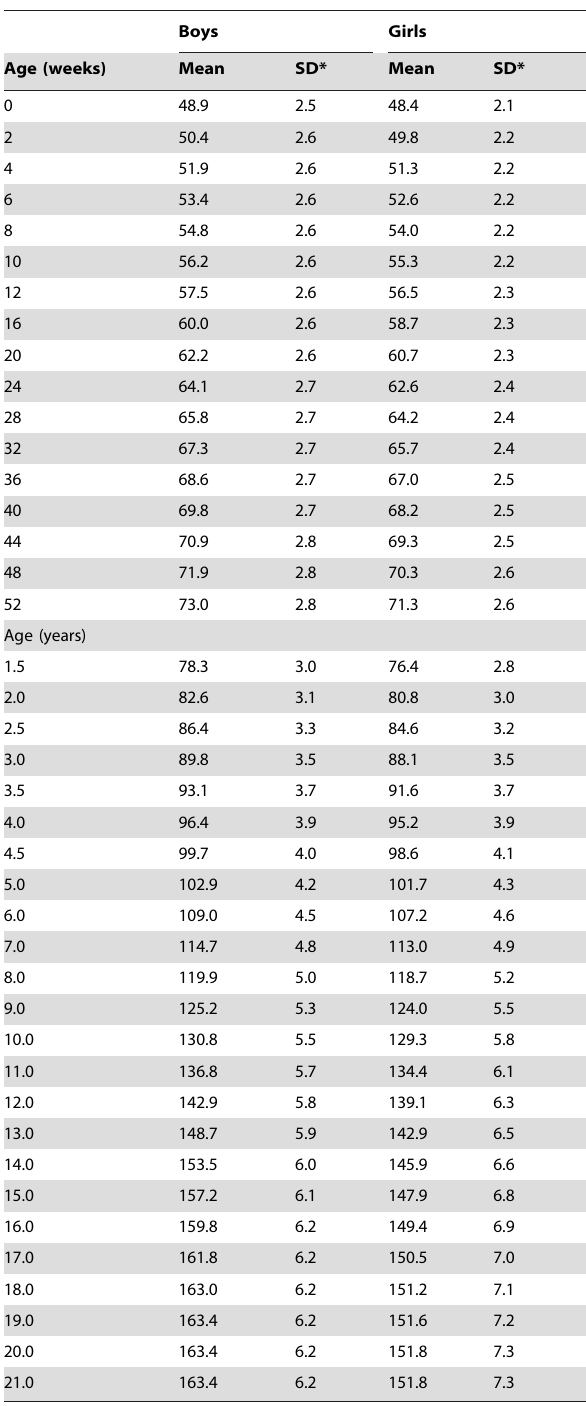
*Individual height SDS can be calculated by: SDS=(height (cm) 2 mean height (cm))/SD (cm). Abbreviations: SD – standard deviation, SDS – standard deviation score.